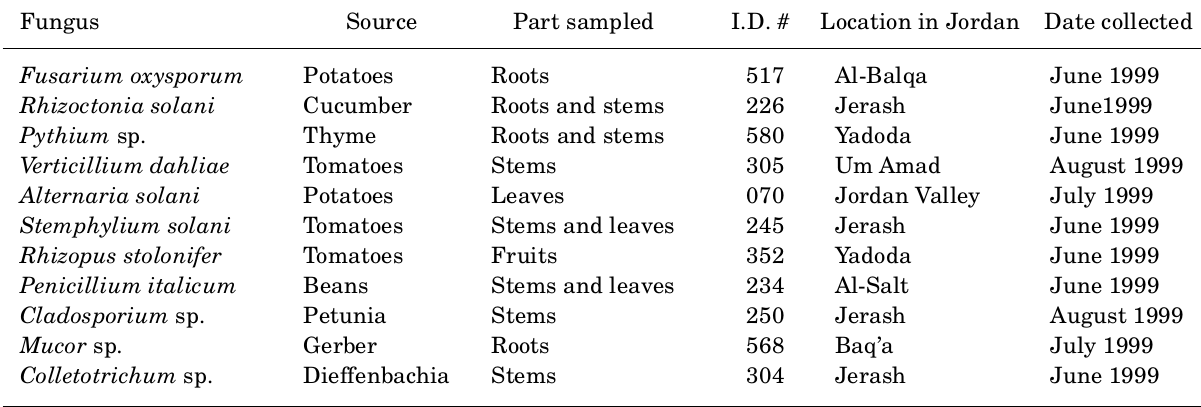
Table 1. Fungal isolates used to study the fungitoxic activity of crude extracts from roots of Ferula harmonis . Fungus Source Part sampled I.D.